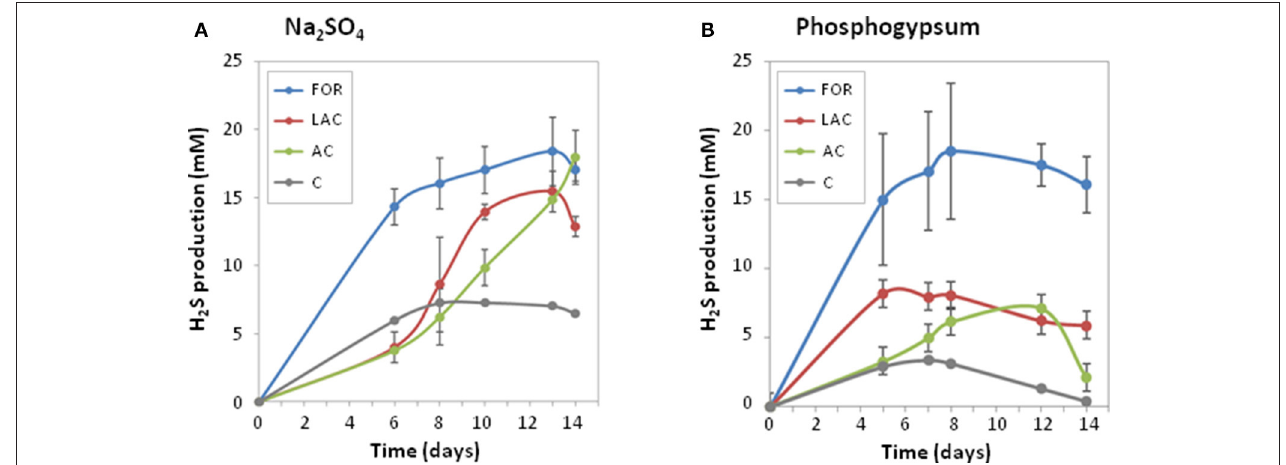
FIGURE 2 | Profiles of hydrogen sulfide production during 14 days of enrichment cultures from coastal marine sediment (as inoculum) using different electron donors (AC, acetate; FOR, formate; LAC, lactate; C, control without electron donor) and sulfate sources: sodium sulfate (A) or phosphogypsum (B) . Values are means of two biological replicates ± confidence intervals (error bars).